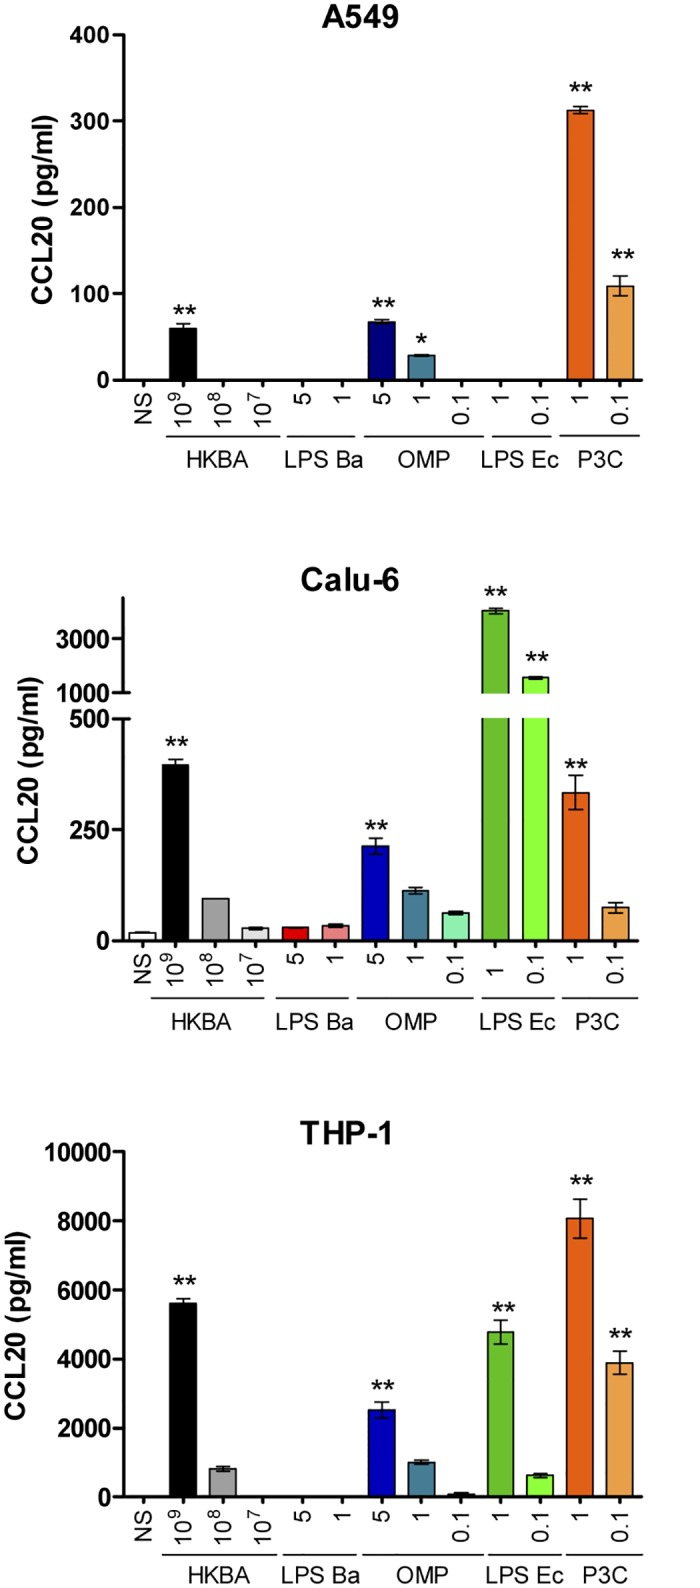
CCL20 production by lung epithelial cells and monocytes in response to B. abortus antigens and TLR agonists.Cells were stimulated for 24 h with heat-killed B. abortus (HKBA), the L-Omp19 lipoprotein (OMP, recombinant form obtained in E. coli) or the LPS from B. abortus (LPS Ba), or with the TLR agonists LPS from Escherichia coli (LPS Ec), and the lipohexapeptide Pam3CSK4 (P3C) (agonists for TLR4 and TLR2 respectively). The concentration of CCL20 in culture supernatants was determined by ELISA. Data are expressed as mean ± SEM of values from three independent experiments. Asterisks indicate statistical significant differences (*, p < 0.05; **, p < 0.01) as compared to non-stimulated cells (NS). (ANOVA followed by Dunnett’s Multiple Comparison test).